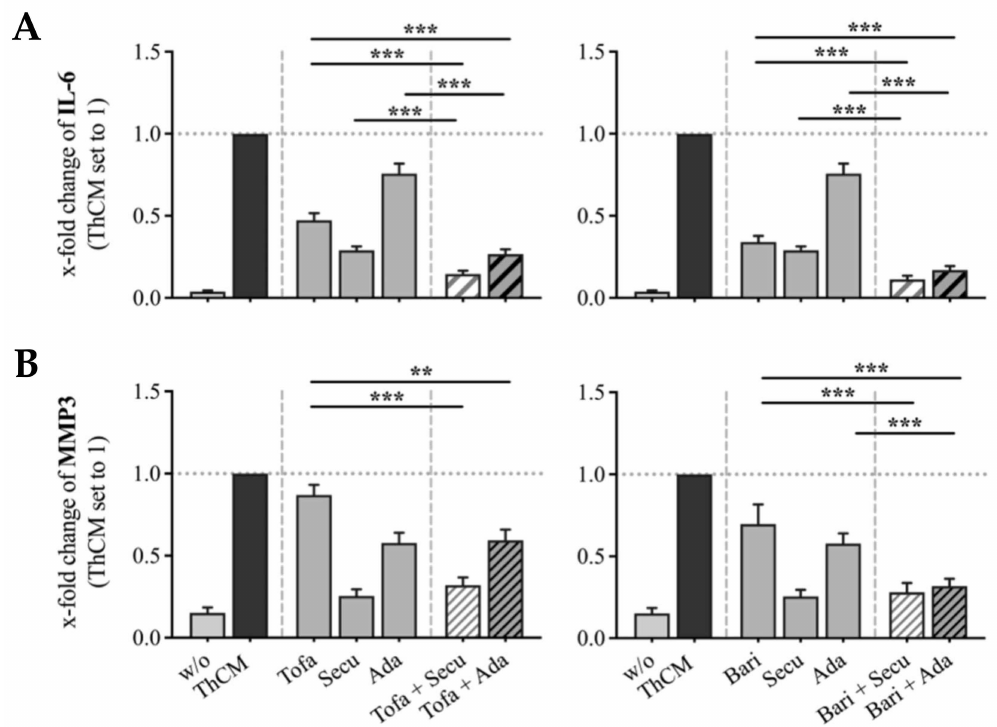
Figure 4. Individual and combined effects of tofacitinib, baricitinib and bDMARDs on IL-6 ( A ) and MMP3 ( B ) secretion by SF stimulated with ThCM. SF (OASF ( n = 6), RASF ( n = 6)) were cultured in the presence or absence of ThCM and treated with JAKi or bDMARDs individually or in combinations as indicated. Supernatants were collected on day 5 and IL-6 and MMP3 quantified by ELISA. Results are presented as x-fold change with SF stimulated with ThCM set to 1. Concentrations used: tofacitinib 1 µ M, baricitinib 1 µ M with either secukinumab 100 µ g/mL or adalimumab 100 µ g/mL. n = 12. Data shown as mean with SEM, significance tested using Wilcoxon signed-rank test, p *** ≤ 0.001, p ** ≤